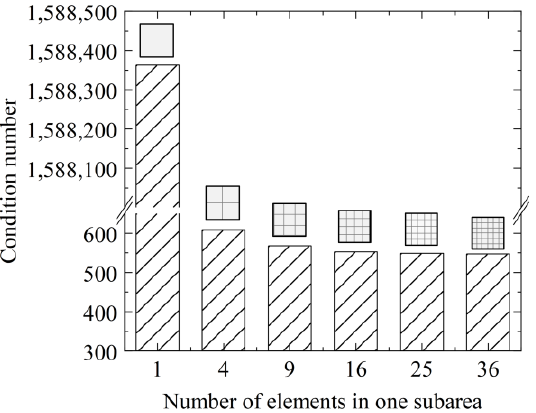
Figure 7. Condition number changes of matrix A versus number of elements in one subarea.